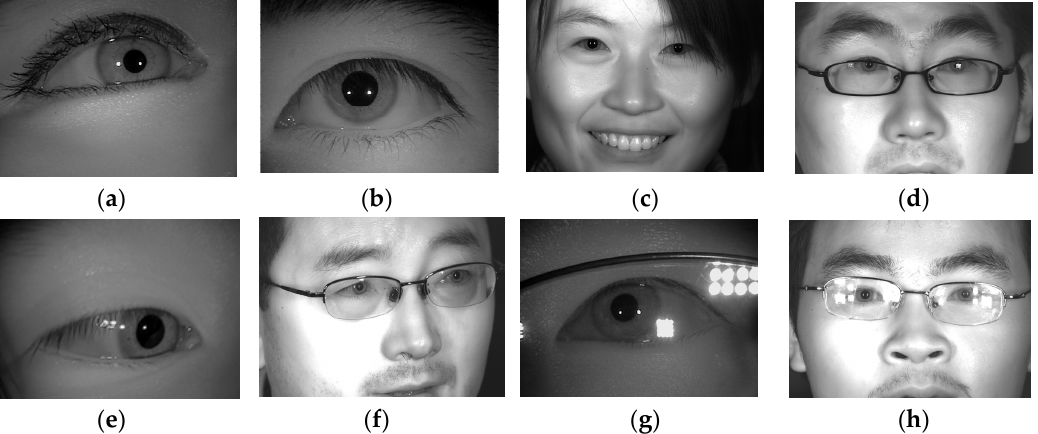
Figure 1. Some typical iris images obtained in non-cooperative environments: ( a ) iris obscured by eyelids; ( b ) iris interfered by eyelashes; ( c ) iris obstruction due to hair; ( d ) glasses obstructing the iris; ( e , f ) off-angle iris; ( g , h ) iris with specular reflection [22].